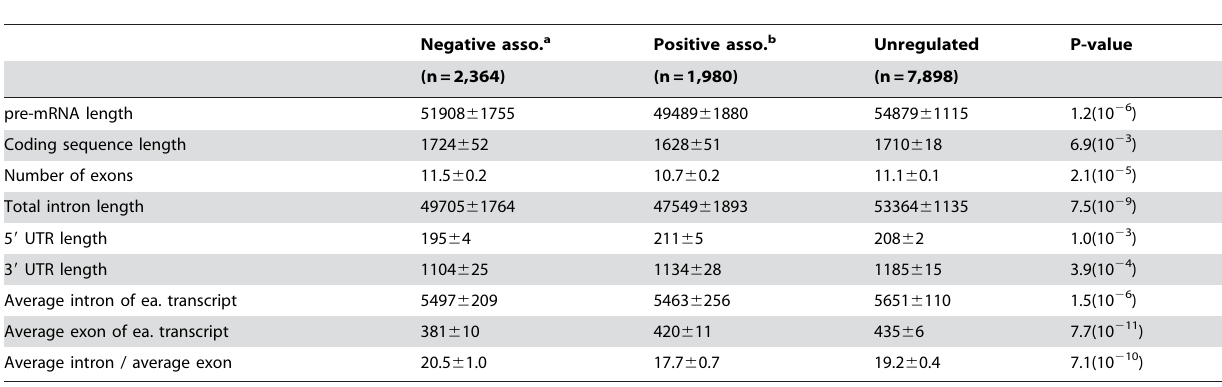
Table 10. Genomic architecture comparisons for age associated genes in human lymphocyte